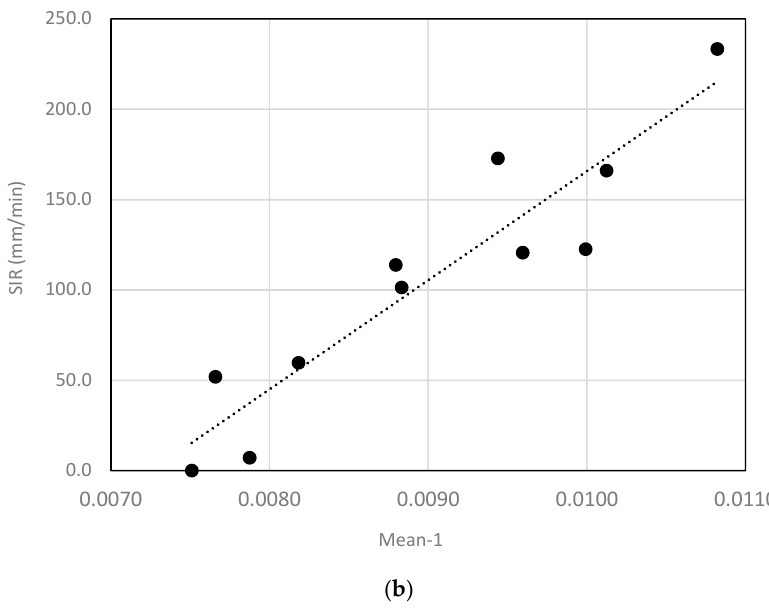
Figure 5. Relationship between inverse of the histogram mean image intensity and the measured surface infiltration rate on the porous asphalt surface using ( a ) the ASTM method (on locations 1–5) and the sample of porous asphalt, and ( b ) the falling head test on locations 1–10 and on the control sample. The dashed lines are the best-fit linear regression lines.